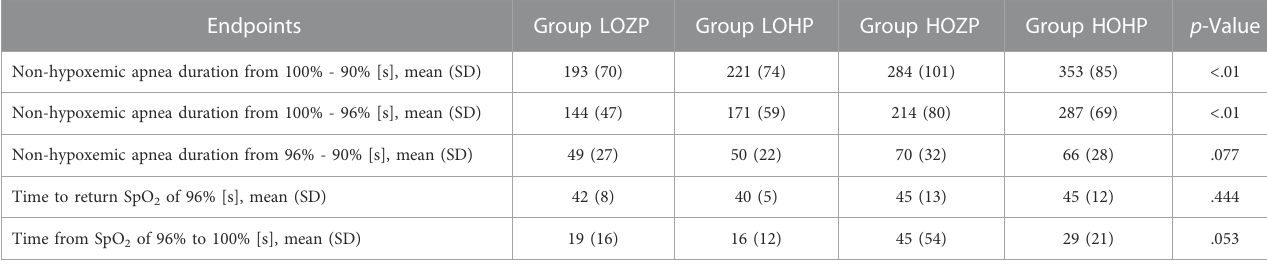
applying 100% oxygen, but not statistically signi fi cant ( p = .077) (Figure 2).